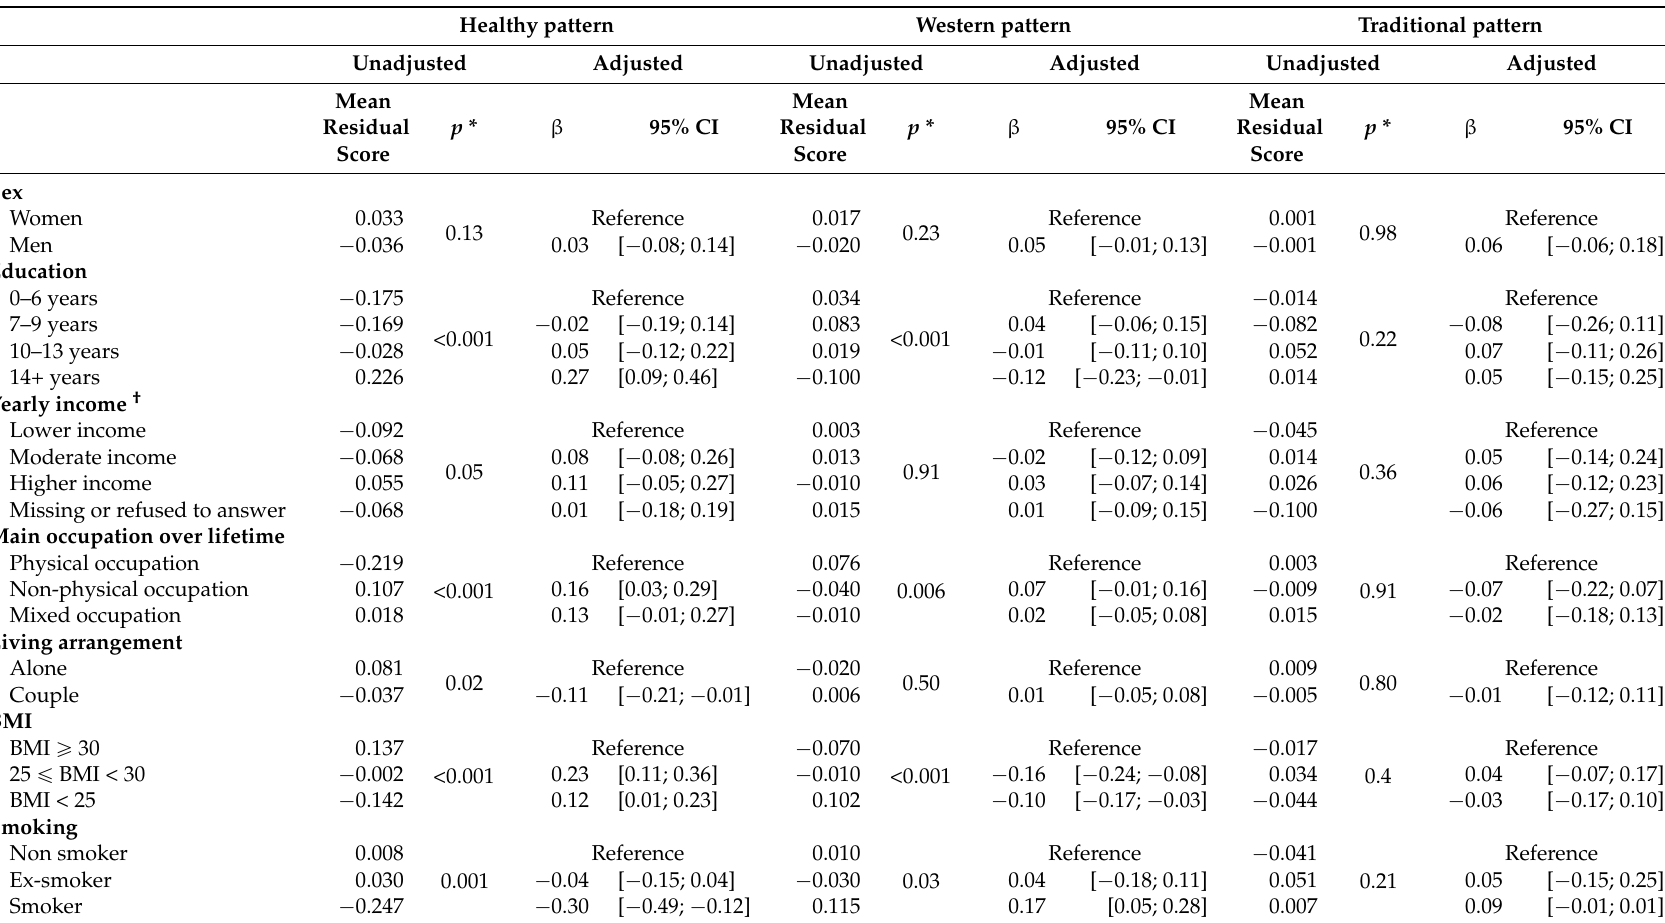
Table 6. Associations between social, health and lifestyle characteristics of the subjects and nutrient patterns in NuAge ( n = 1596). Healthy pattern Western pattern Traditional